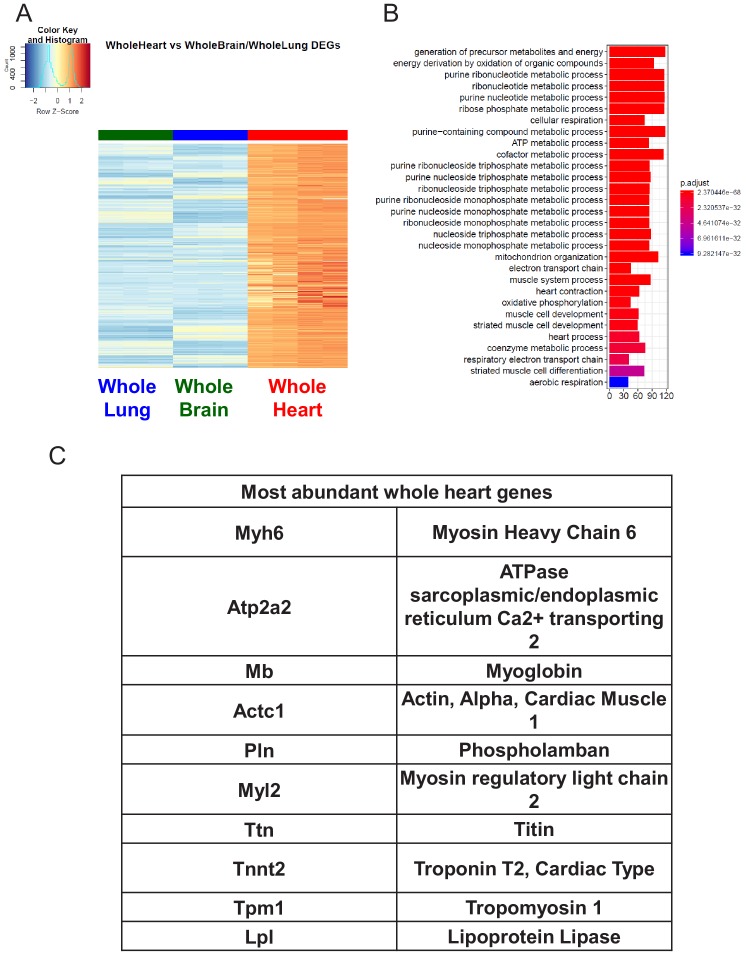
Characterization of Whole Heart RNA-Seq data.(A) Heat map representation of differentially upregulated genes identified by comparing whole heart RNA-Seq samples to whole brain and whole lung tissues at baseline. The blue to white to red gradient represents increasing expression of the pathway with blue representing minimal expression while the red represents high expression of the pathway. (B) The GSEA results of enriched GO terms from whole heart samples at baseline. (C) Top whole heart signature genes ranked in order of abundance.